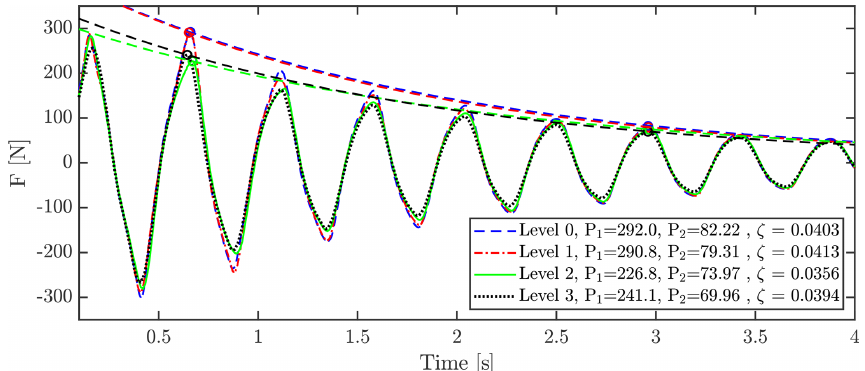
Figure A2. Grid sensitivity study using a different number of cells per block. A total of 158 blocks was used. Level 0 was 64 × 64 × 64 per block, i.e., 41418752 cells in total. Level 1 was 32 × 32 × 32 per block, i.e., 5177344 cells in total. Level 2 was 16 × 16 × 16 per block ,